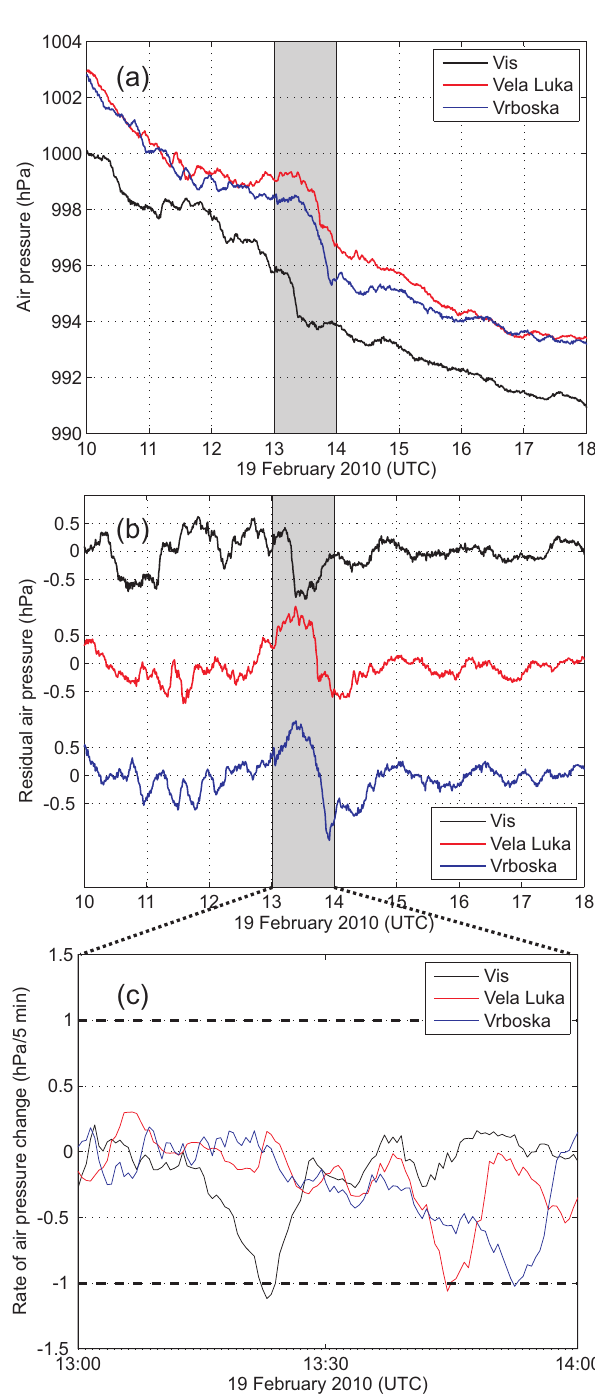
Fig. 3. (a) Air pressure records for the 19 February 2010 meteotsunami event, (b) residual records (after filtering with a 3-h Kaiser-Bessel filter); shaded areas in (a) and (b) show the atmospheric disturbance, and (c) 5-min rates of air pressure change. Dashed lines denote the 5-min rate of air pressure change threshold (1hPa5min − 1